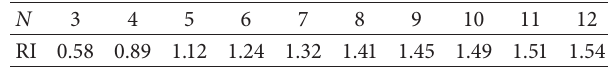
Table 2: Random consistency index (RI) for pairwise